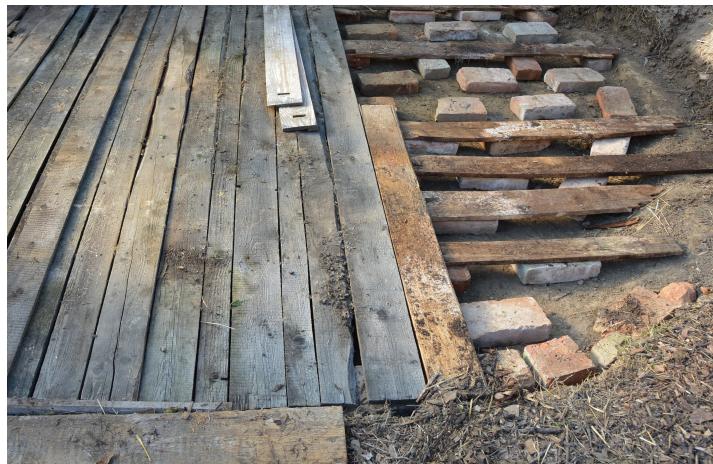
Figure 9. Compost floor—underlaying bricks and wooden panels provide thermal insulation of the composting material from the ground. Figure shows the construction in progress that is almost ready for installation of waterproof plastic layer.